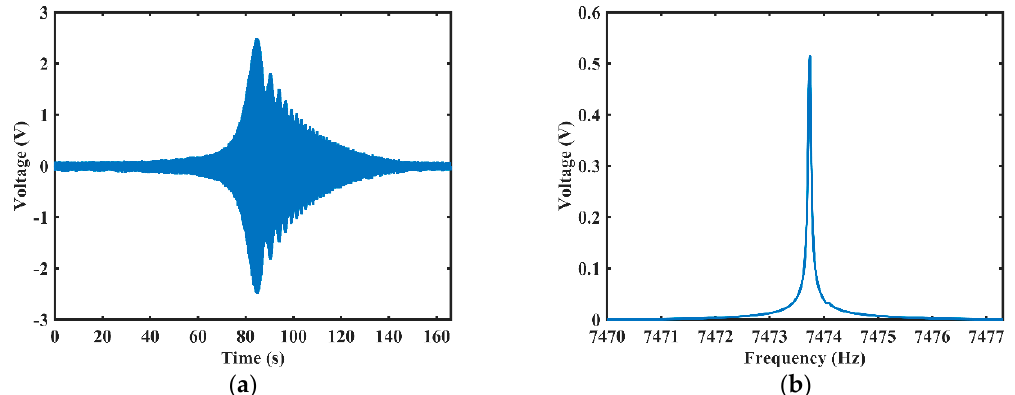
Figure 8. The results of frequency sweeping detected by electrostatic excitation and detection: ( a ) The output voltage signal of the ED; ( b ) Fast Fourier transform (FFT) results of the output voltage signal.